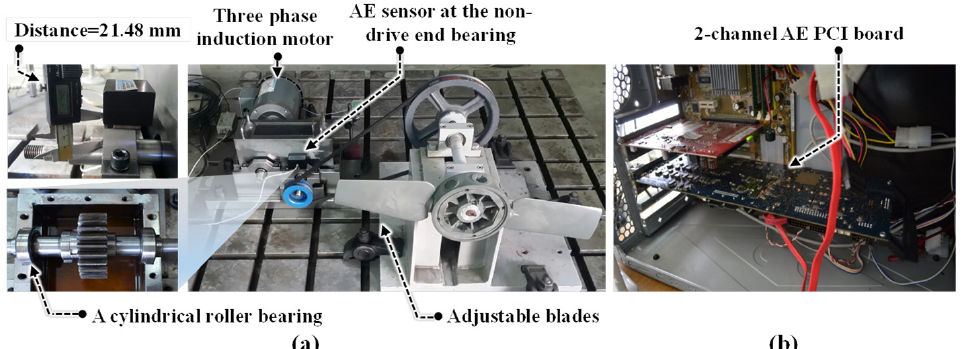
Figure 2. Experimental setup for bearing data collection: ( a ) recording the data and ( b ) acoustic emission data acquisition.